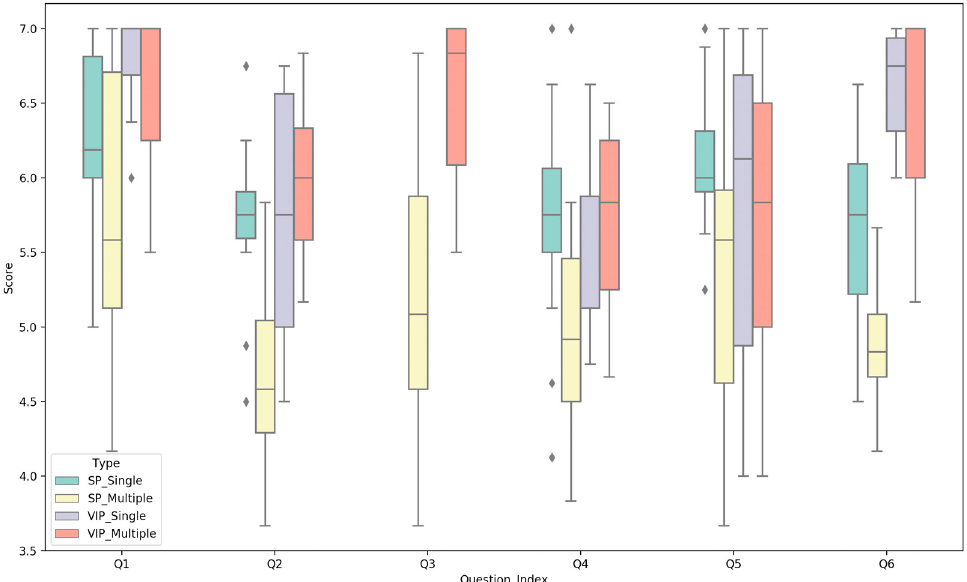
Figure 3. Box chart of subjective questions in different conditions in the control group. Q1 to Q6 indicate six subjective questions for evaluating motion speed perception, trajectory perception, cocktail party effect, perception difficulty, audio comfort, audio and motion adaptation. The score is based on the 7-point Likert scale, where 1 means strongly disagree and 7 means strongly agree.